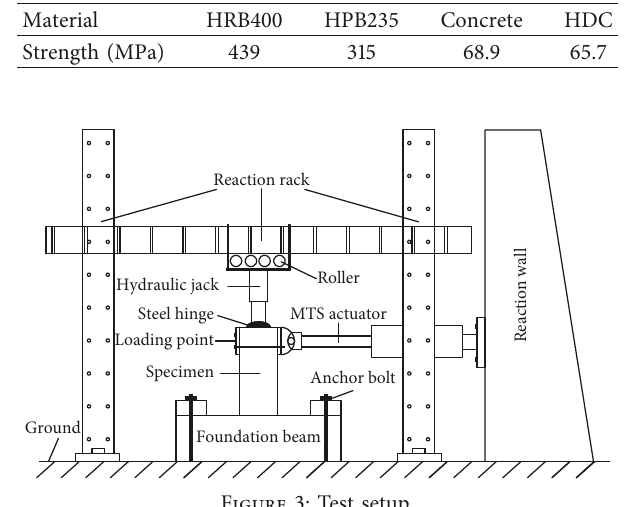
Figure 3: Test setup.